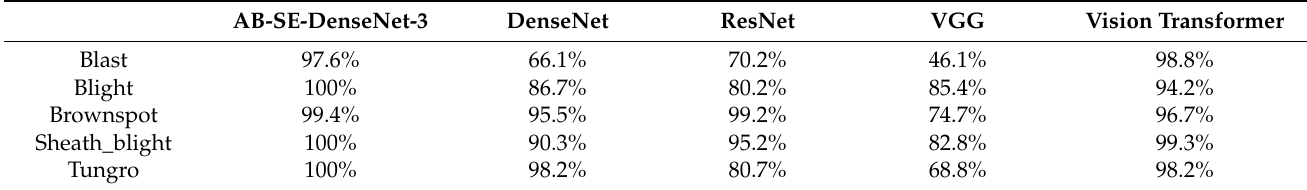
Table 5. Disease recognition accuracy of different models.